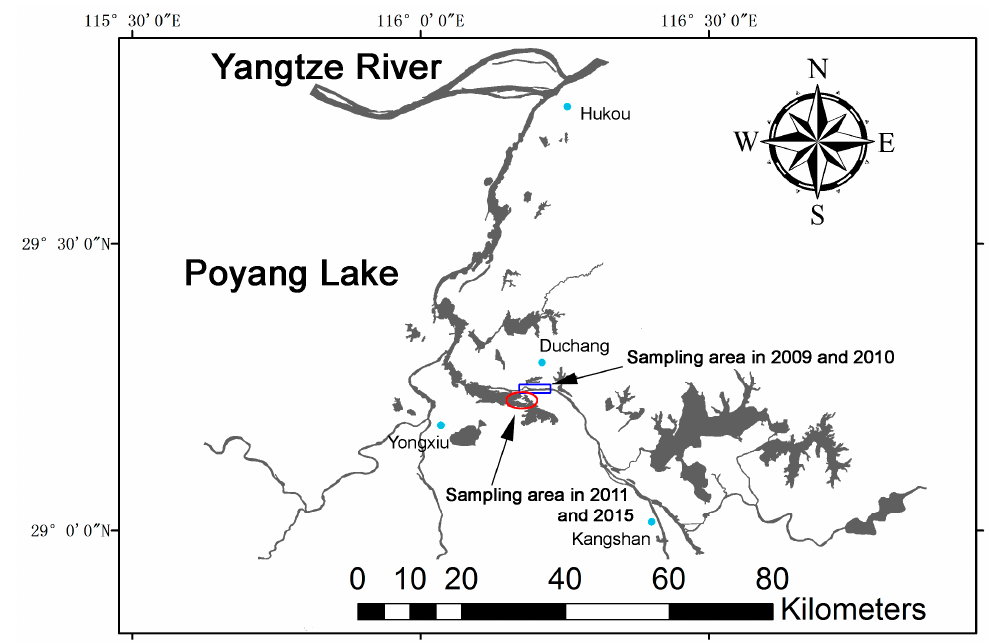
Figure 2. Water coverage of the Poyang Lake in the early spring. Porpoises primarily distribute along the main channel between Hukou and Kangshan, and also in some large sandpit areas between Duchang and Yongxiu. The blue box represents the sampling area in 2009 and 2010. The red circle represents the sampling area in 2011 and 2015.